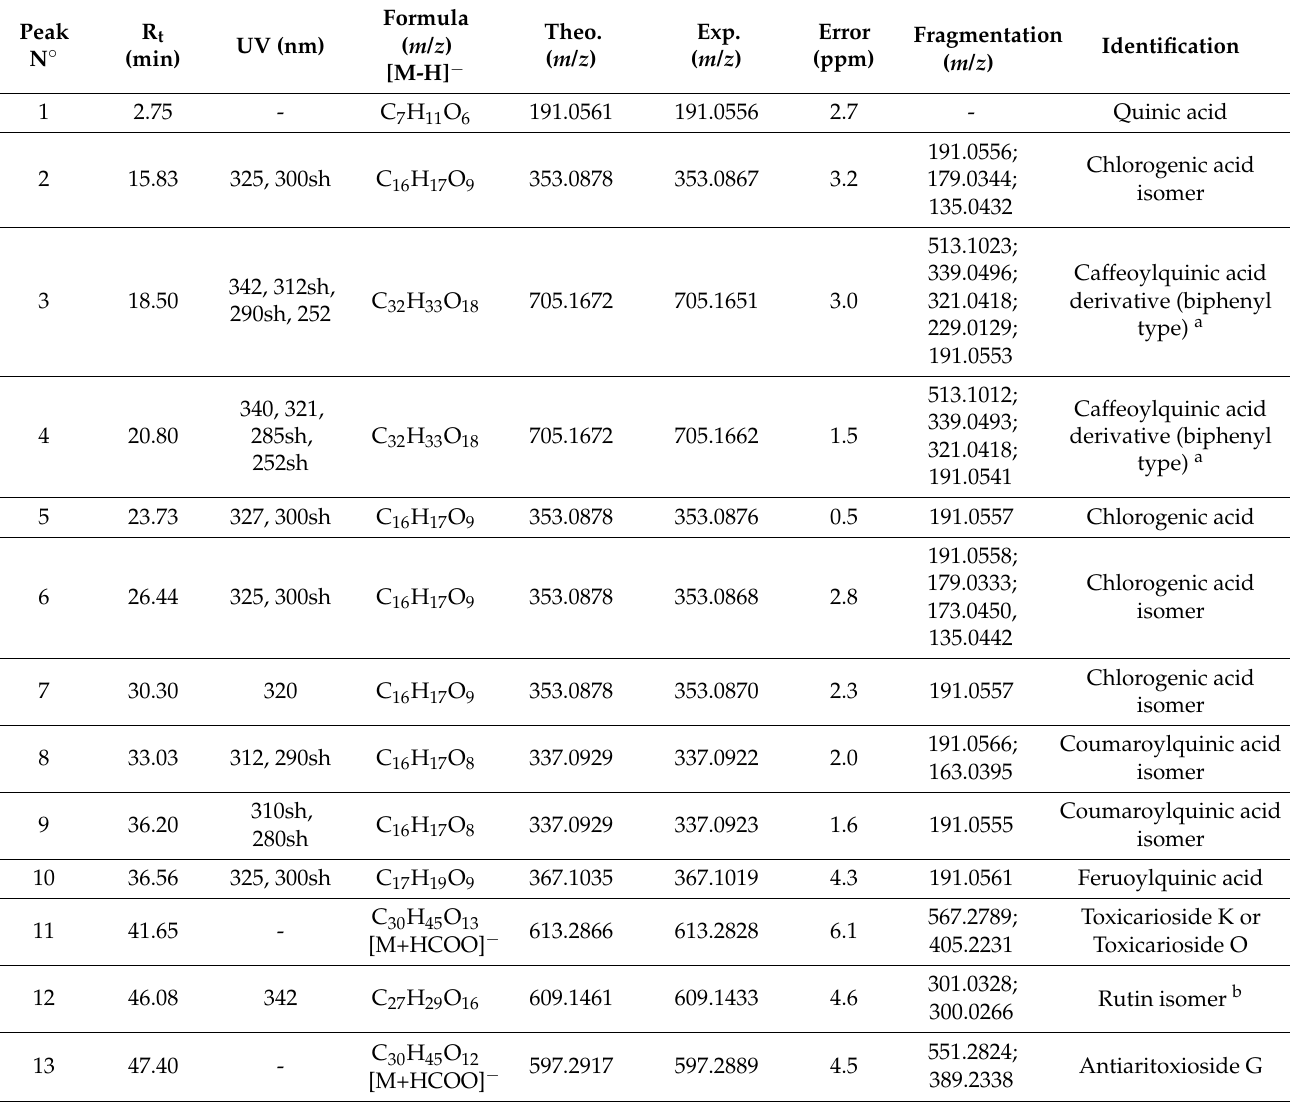
Table 1. UPLC-DAD-QTOF-MS/MS data of identified compounds in EHA-Aq